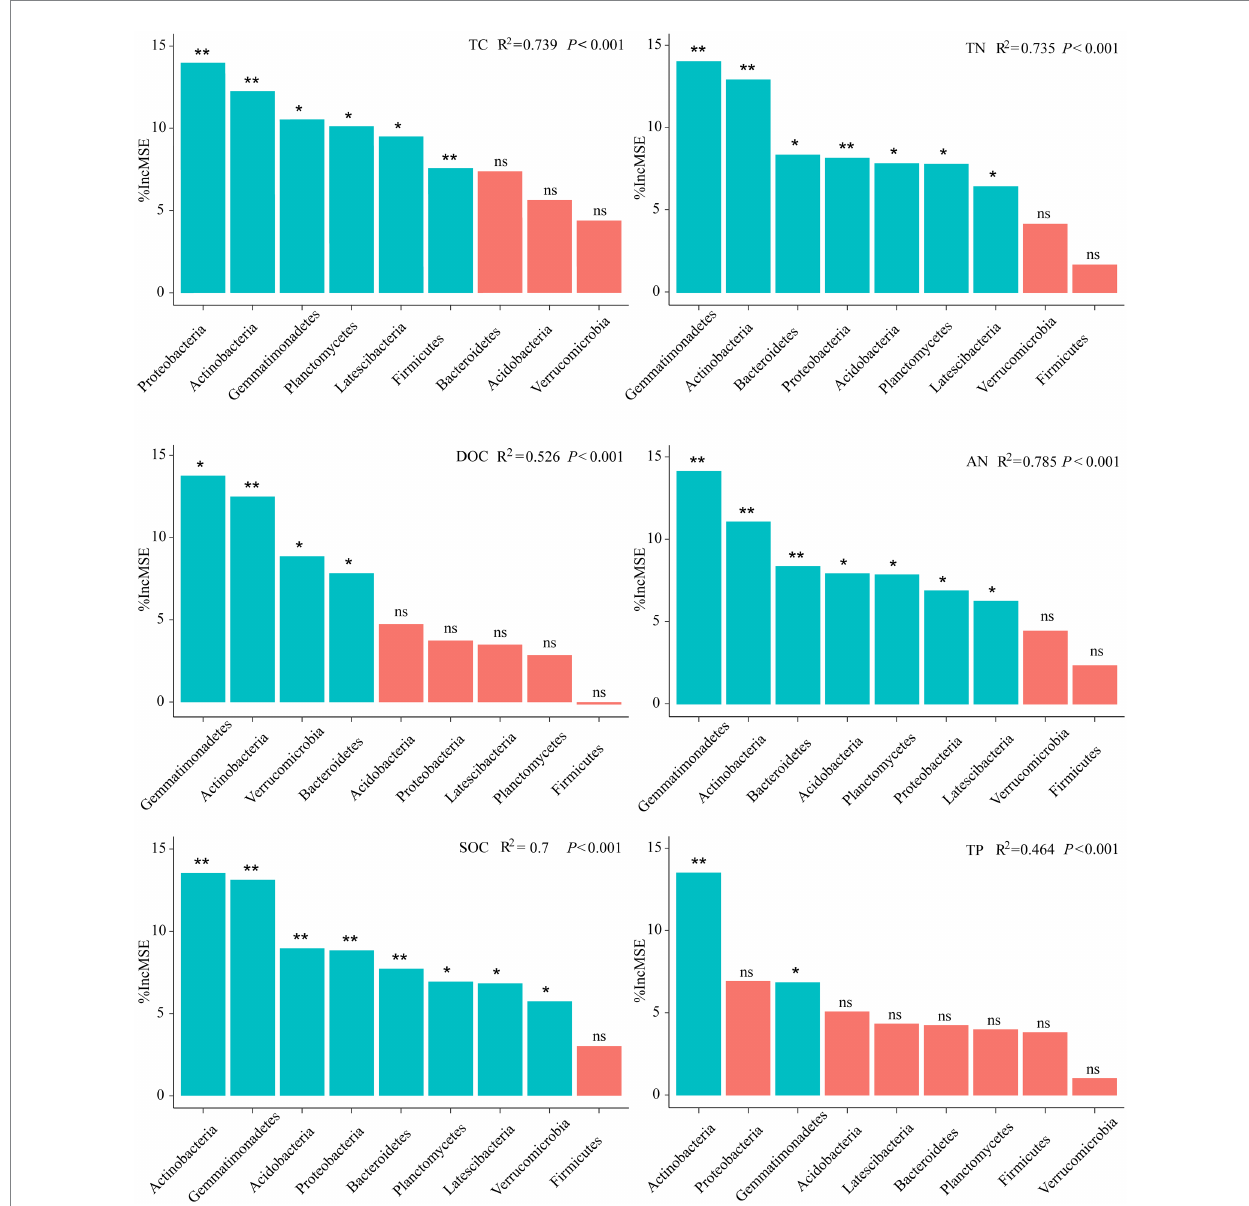
FIGURE 3 Main potential bacteria contribute to soil multi-nutrient cycling in the alpine ecosystem under warming. The importance of these predictors was estimated using the percent increase in the MSE of the variables, with higher MSE% values indicating more important predictors. The p < 0.05 (*) and p < 0.01 (**) indicate significance at the levels of 5% and 1%,